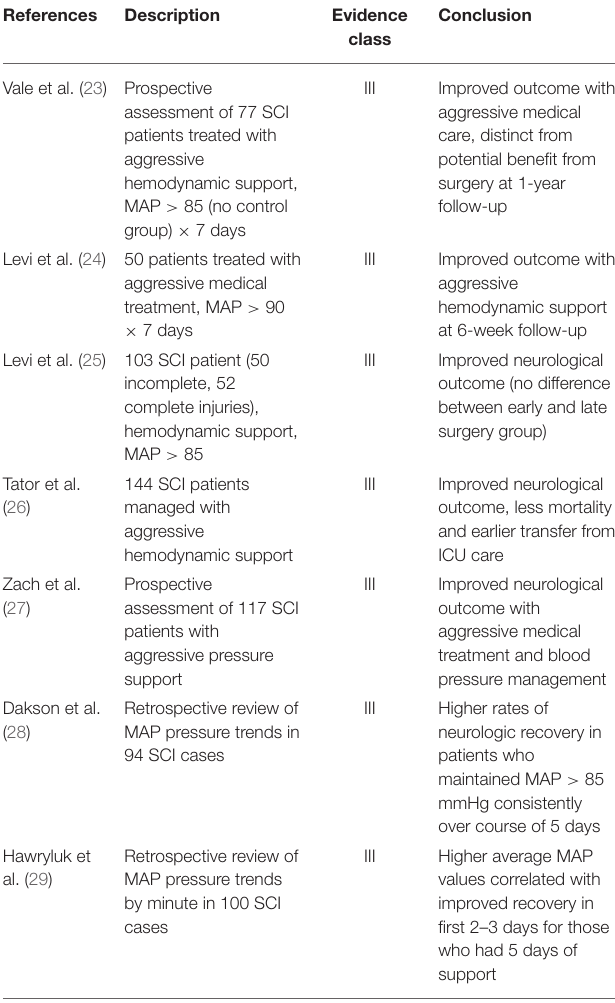
TABLE 2 | Summary of association between mean arterial pressure and neurological outcome in acute spinal cord